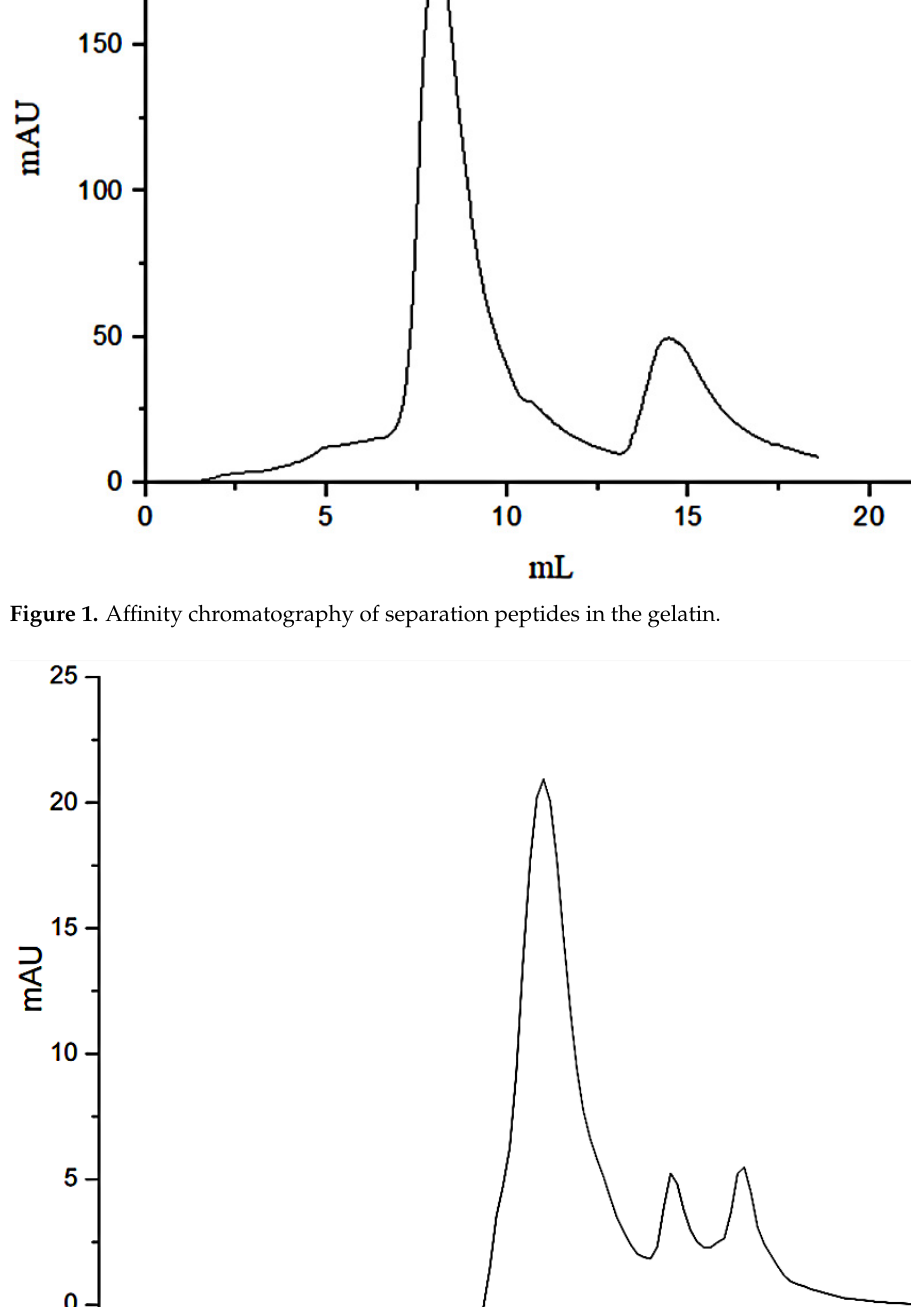
Figure 2. Gel filtration chromatograms of the desalinated peptide fraction.